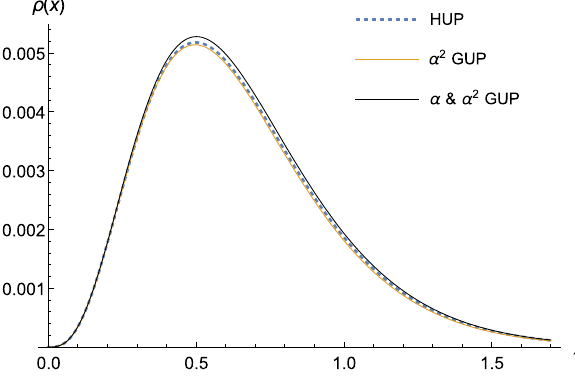
Fig. 7 The total energy density ρ( x ) versus the variable x for massless fermions in a general static spherically symmetric spacetime, where a = 0 .